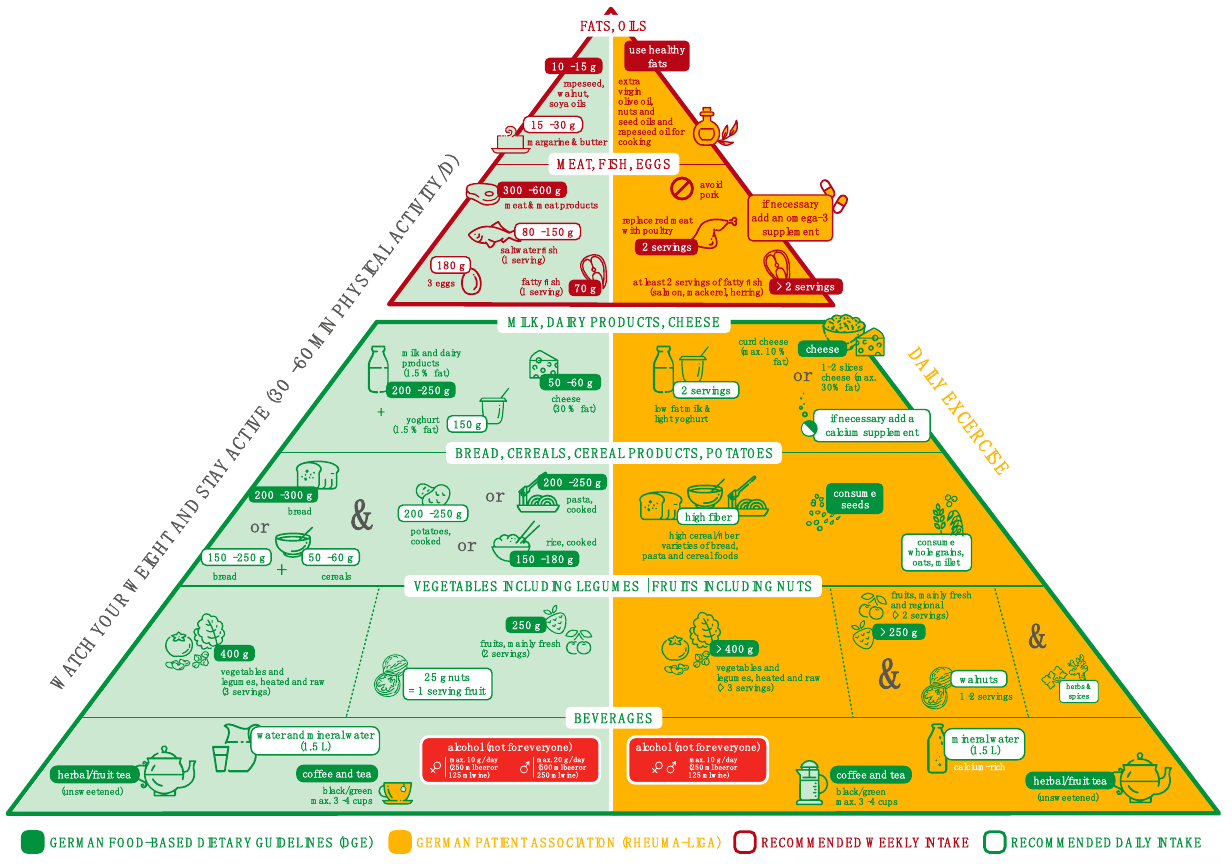
Figure 1. Food pyramid including German food-based dietary guidelines (DGE) and German patient association (Rheuma-Liga) recommendations for a wholesome diet.